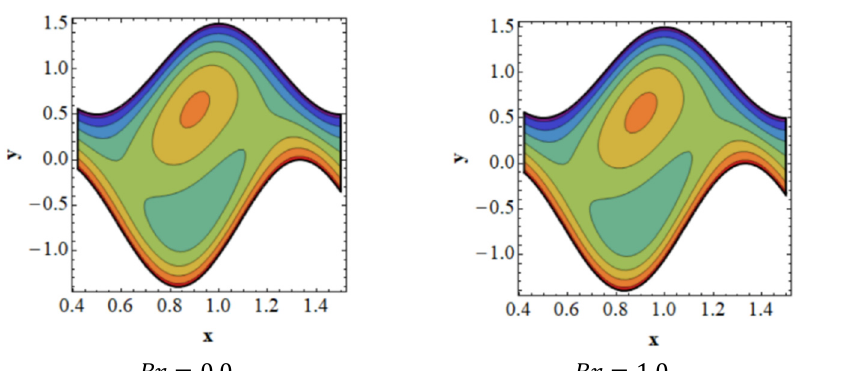
Figure 9. Consistency of streamlines for values of ξ 3 .